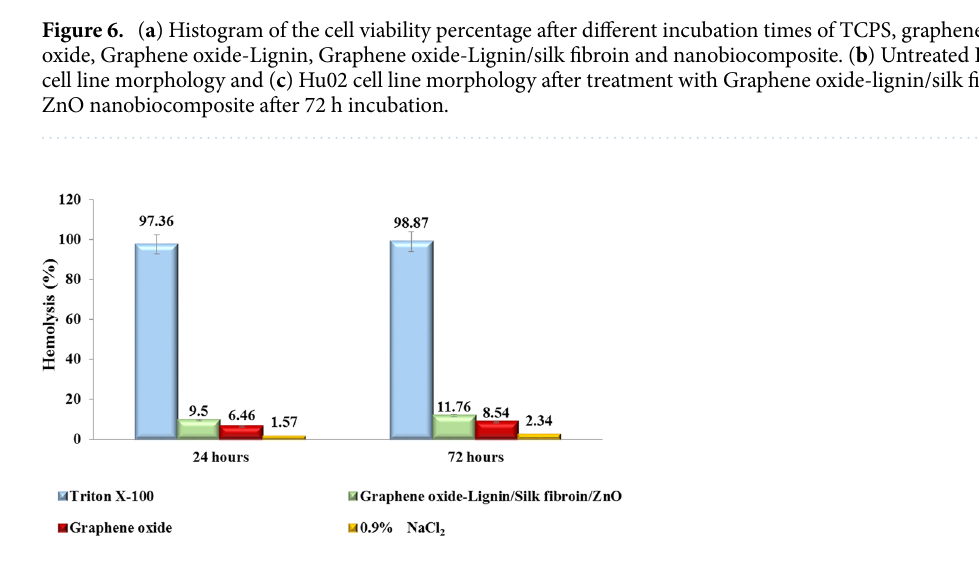
Figure 7. Hemolysis histogram of 1% Triton X-100 (positive control), 0.9% NaCl (negative control), graphene oxide and Graphene oxide-lignin/silk fibroin/ZnO nanobiocomposite after different extraction times (24 h and 72